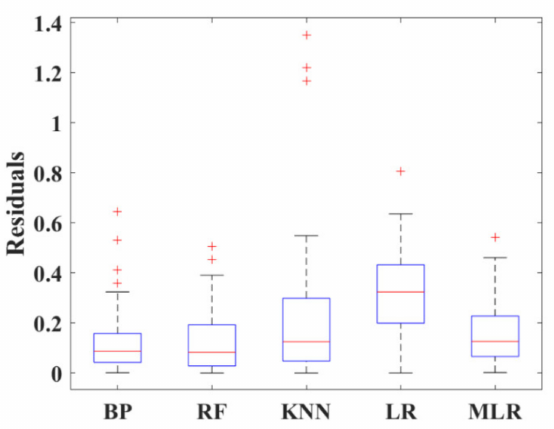
Figure 17. Box diagram of 5 models.